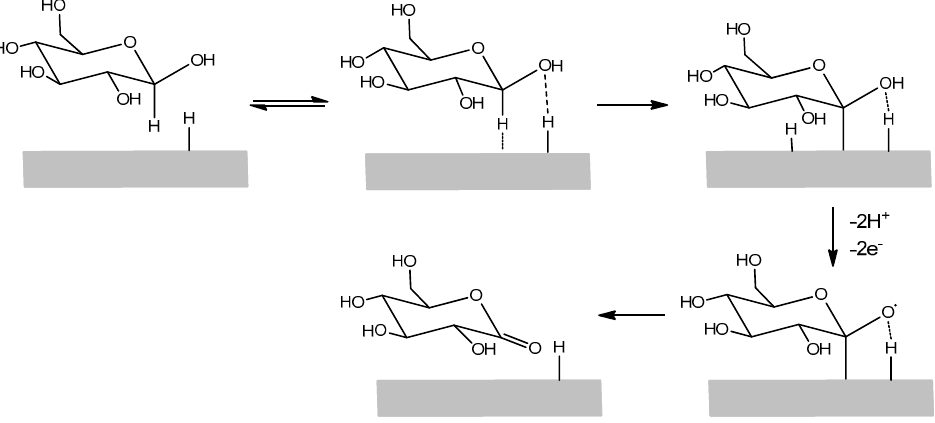
Figure 6. Simplified scheme of glucose electrooxidation mechanism on a Pt surface.